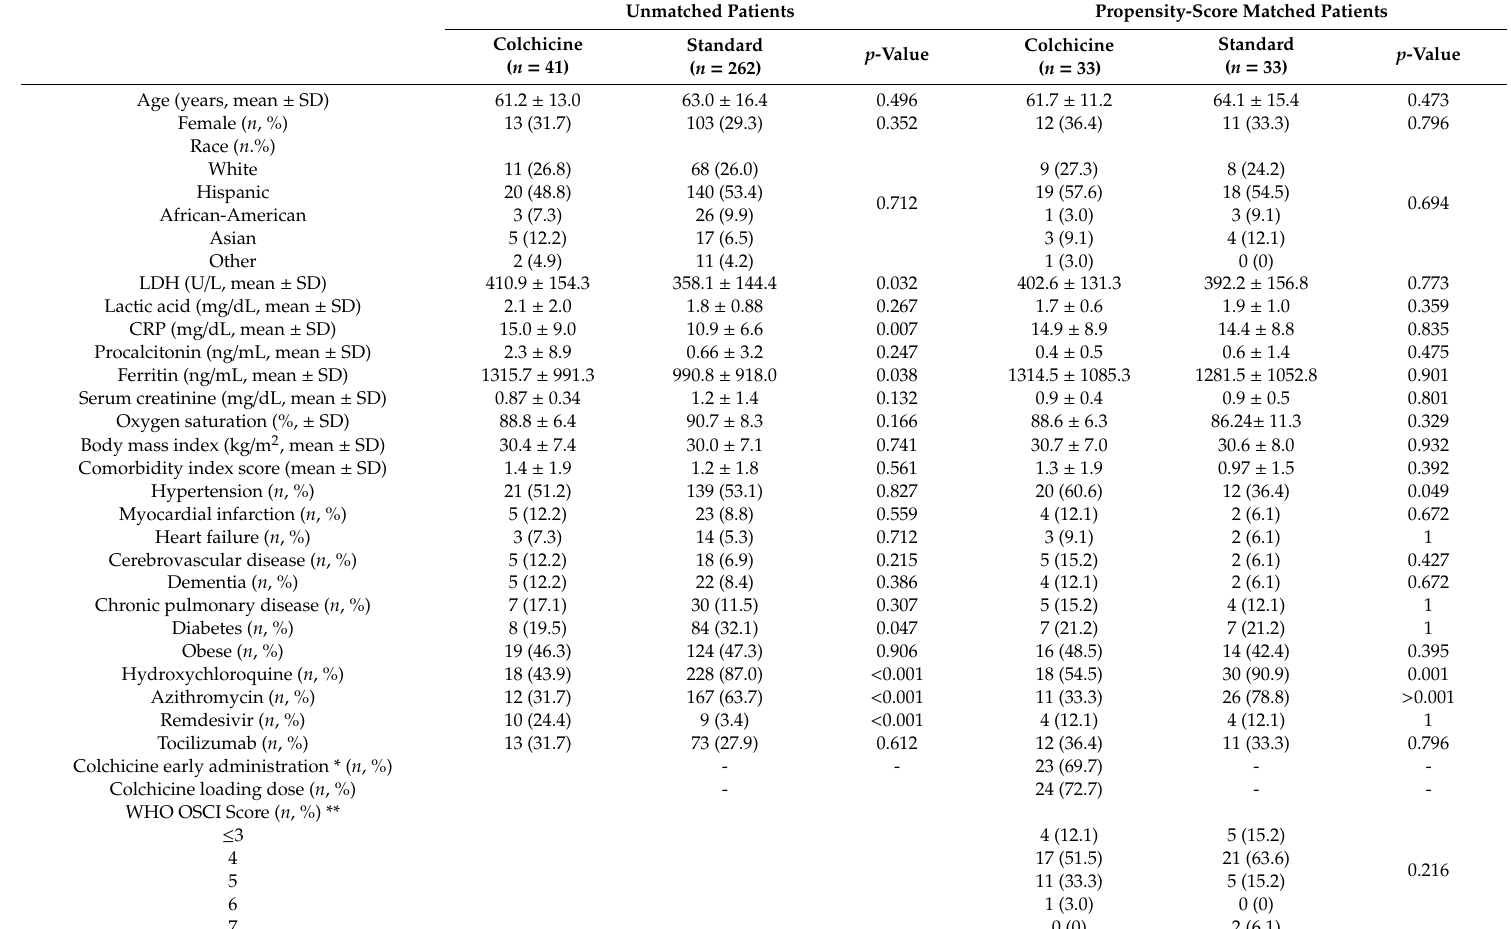
Table 1. Patient demographic and clinical characteristics before and after propensity score